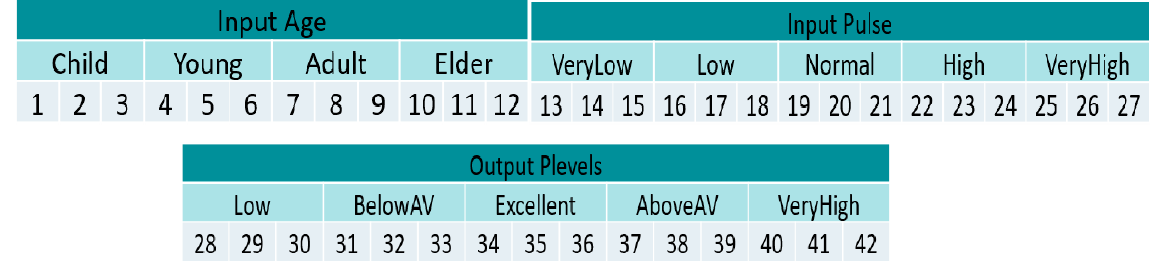
Figure 18. IT2FS representation in the BSA with Gaussians MFS.